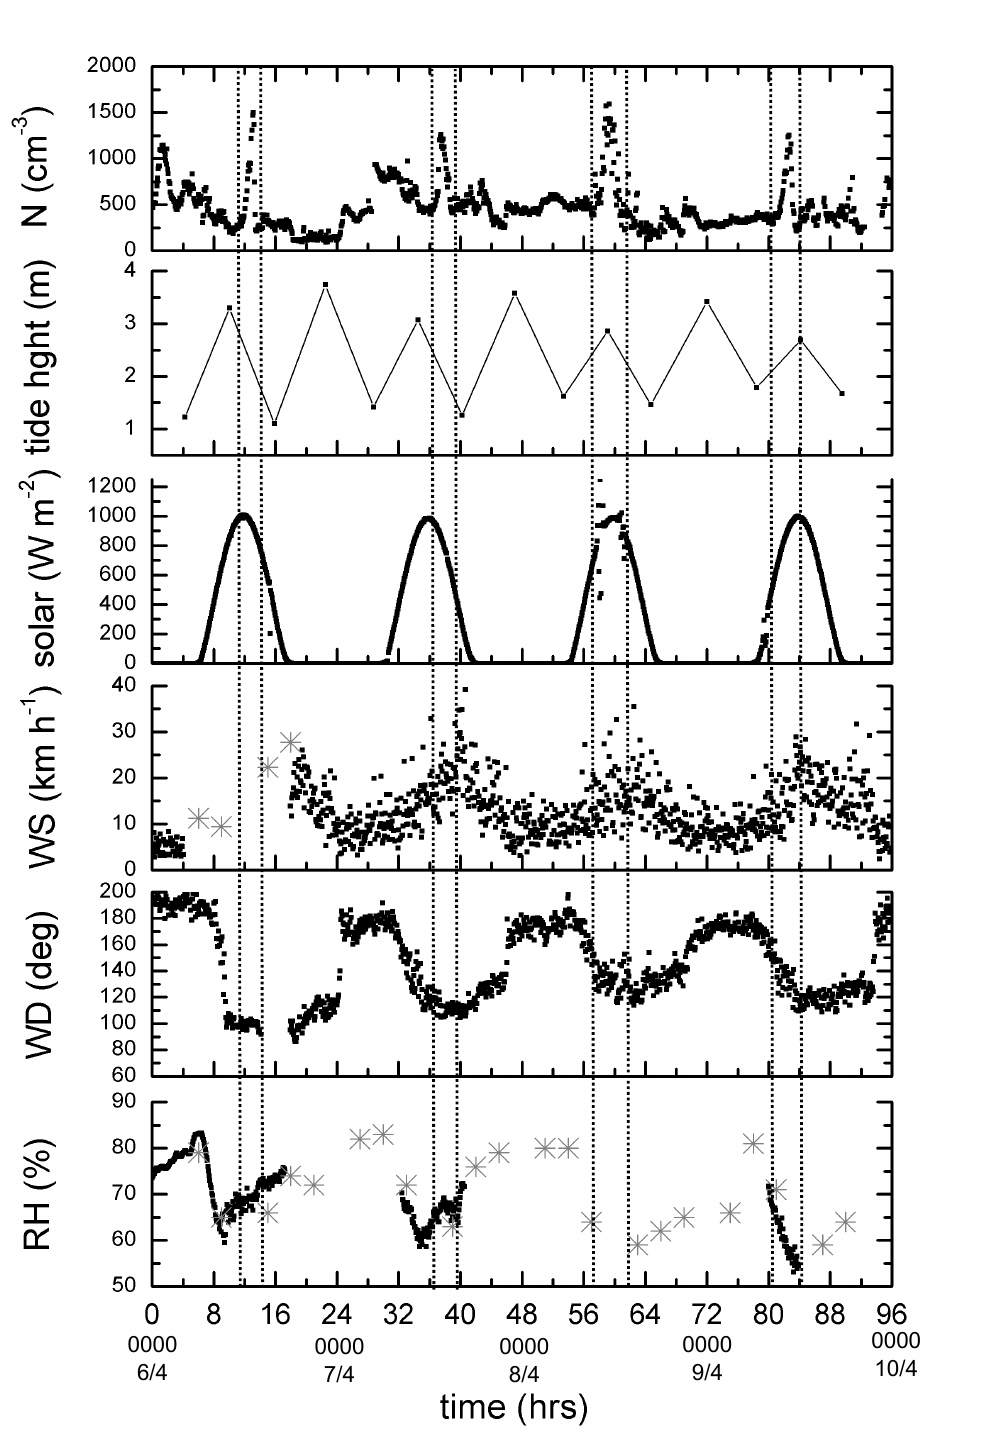
Fig. 7. Time series of particle concentration (4 < d < 165nm), N (cm − 3 ); tide height at Agnes Water, tide hgt (m); solar intensity, solar (Wm − 2 ); wind speed, WS (kmh − 1 ); wind direction from true north, WD (deg); and relative humidity, RH (%) for 6 to 9 April 2007. Dashed lines indicate the occurrence of 4 weak nucleation events. Grey asterisks represent data collected from a nearby (Town of 1770) Australian Bureau of Meteorology weather